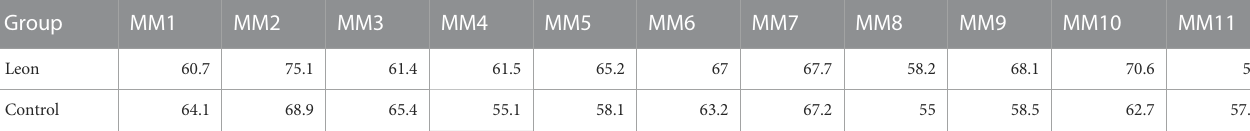
TABLE 6 The proportion of moDCs in the harvested cells (%) (MM patient-moDCs, n = 11).